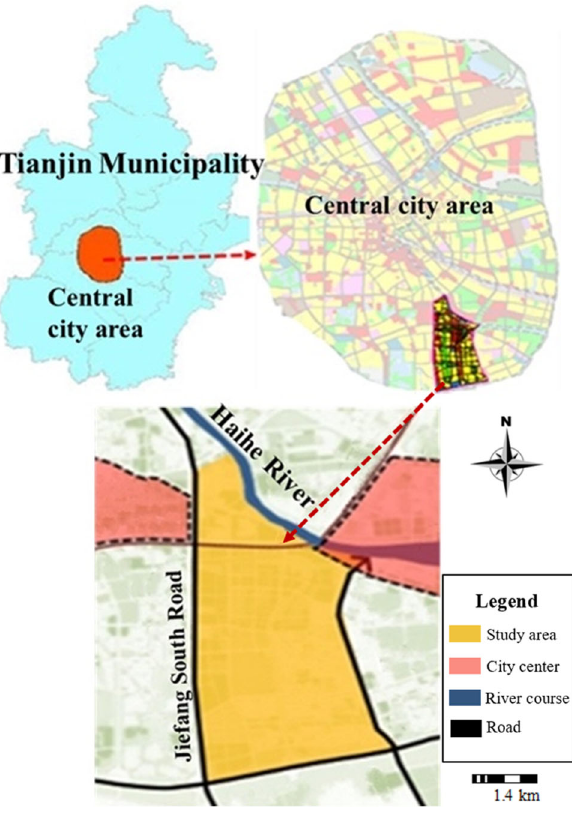
Fig. 4 Schematic diagram of the location of the drainage area on Jiefang South Road in Tianjin Municipality,